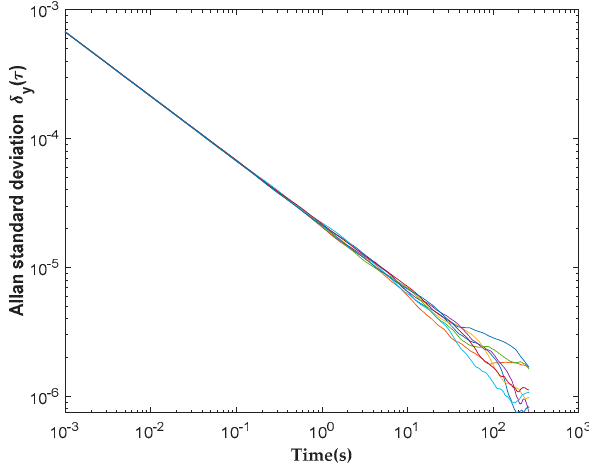
Figure 15. Allan standard deviation for eight cross-correlator channels .